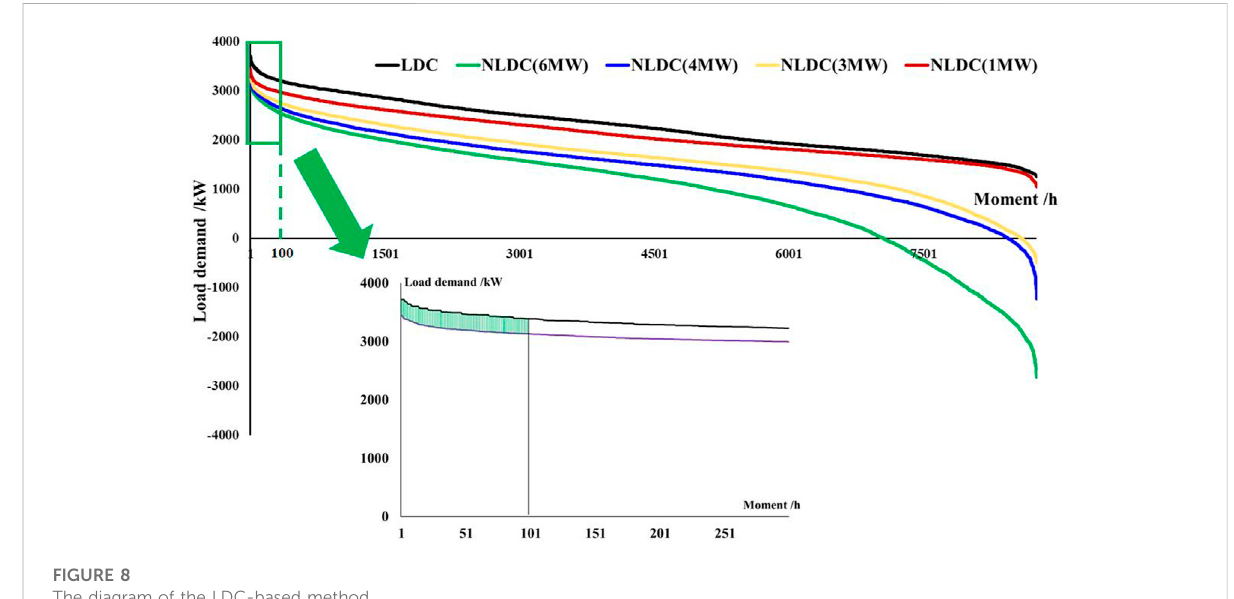
FIGURE 8 The diagram of the LDC-based method.